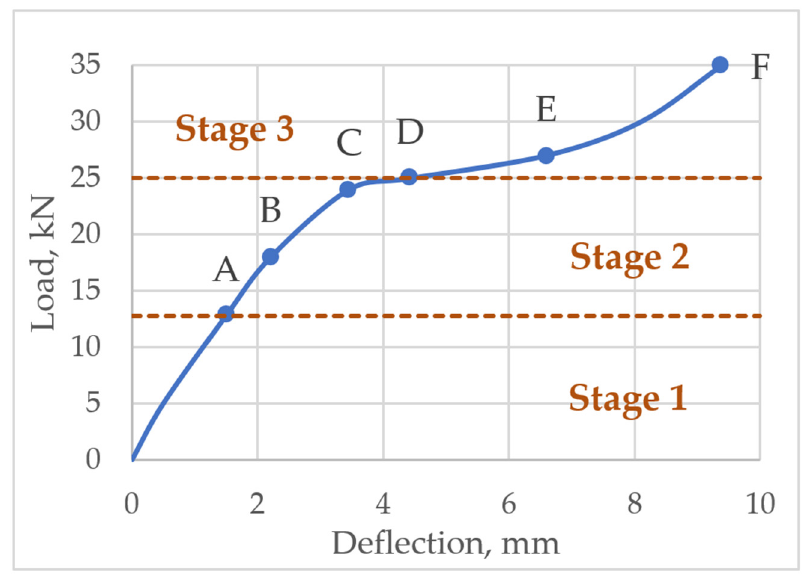
Figure 9. The levels of slab loading.